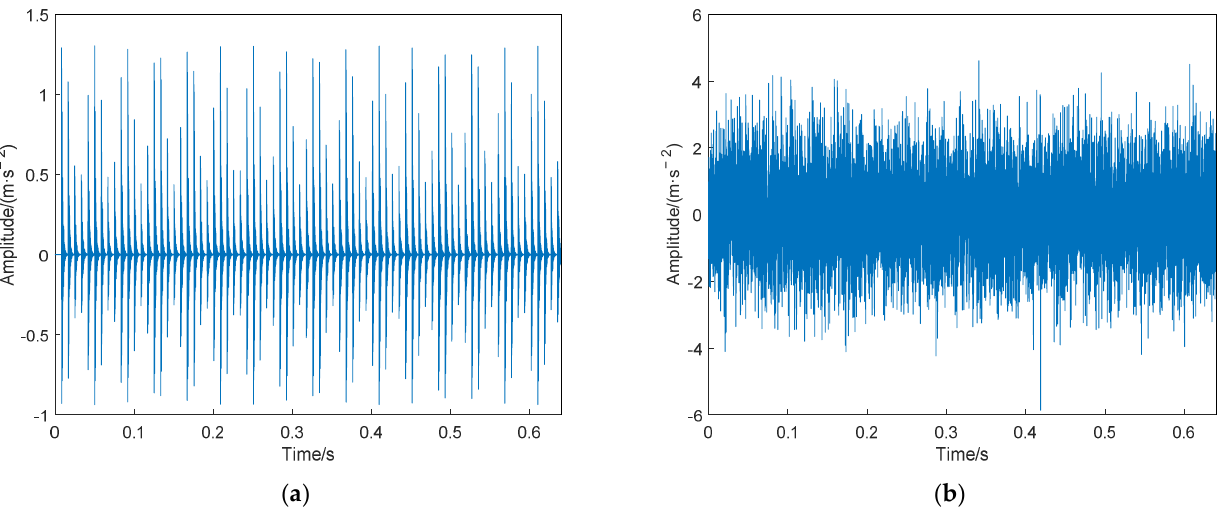
Figure 2. Time-domain waveforms of the original and noisy signals: ( a ) the original signal’s time- domain waveform; ( b ) the time-domain waveform with a noisy signal.